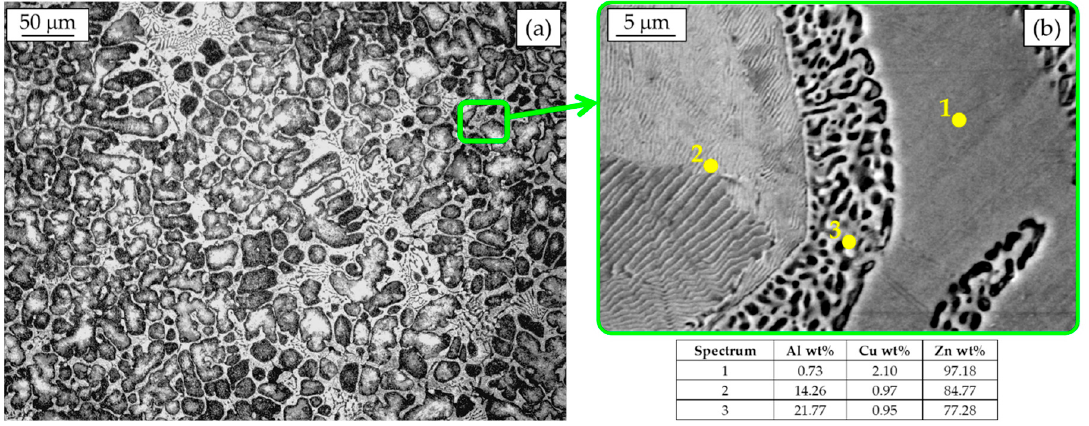
Figure 4. Hyper-eutectic ZEP microstructure ( a ) and SEM-EDS analysis ( b ).